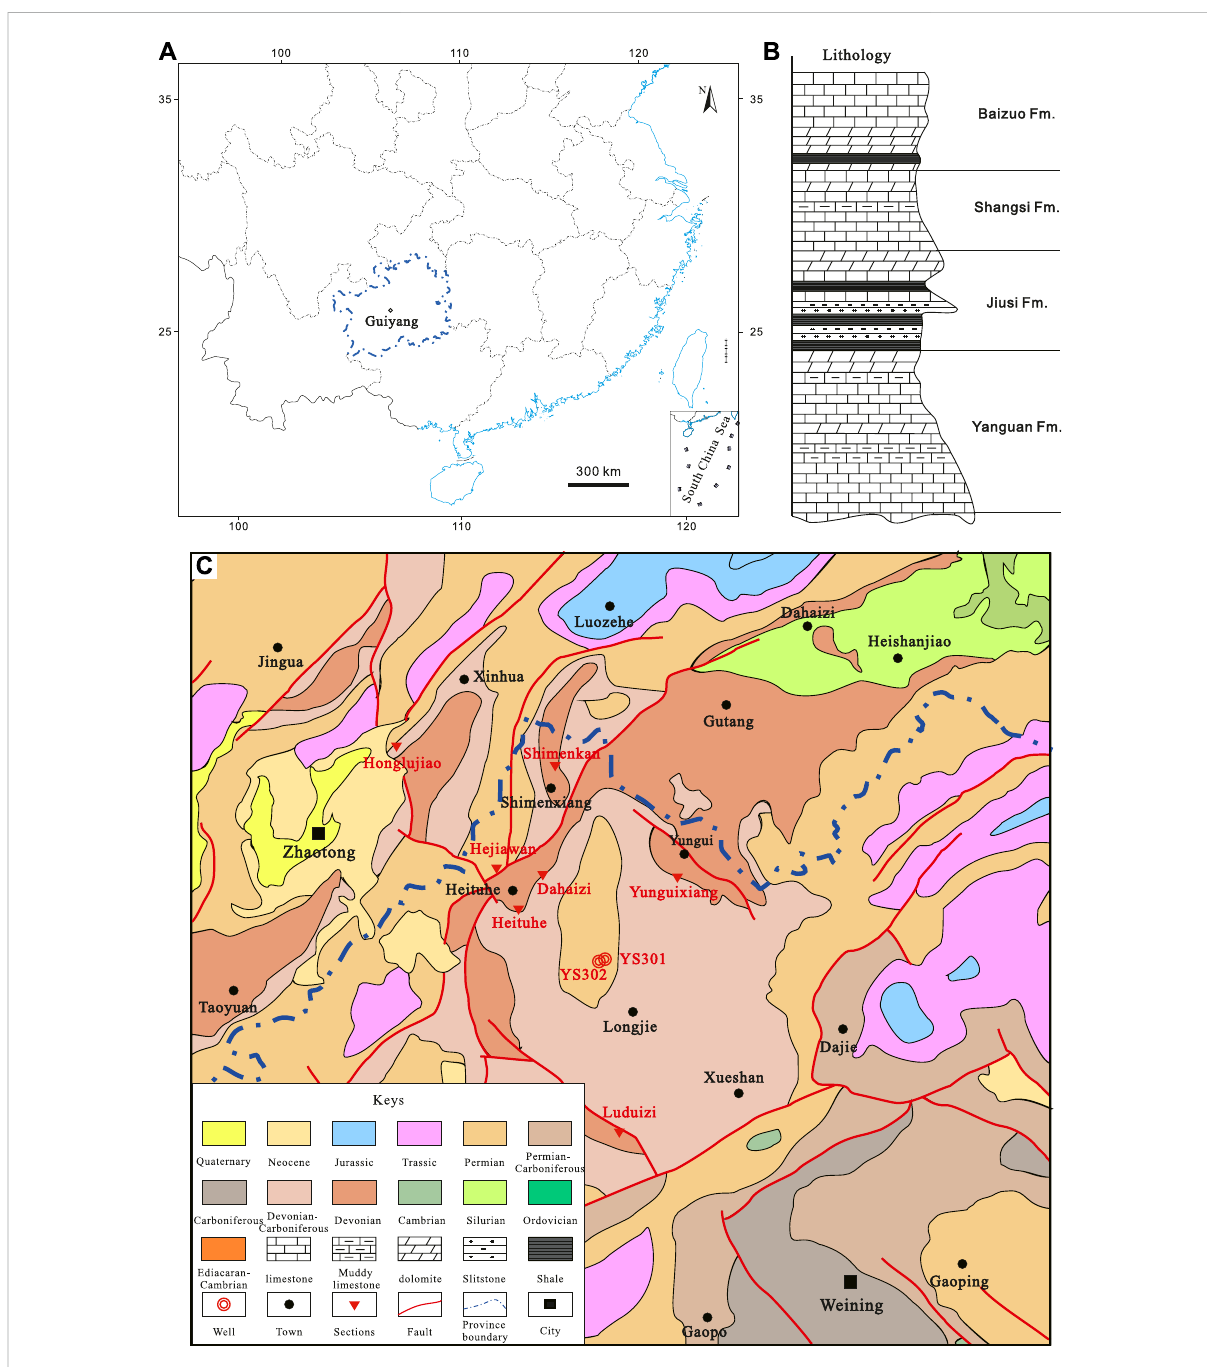
FIGURE 1 Location and general geological structure of the study area. (A) Occurrence of Guizhou Province in China. (B) The lithology of the Lower Carboniferous in the study area, northeastern Guizhou (modi fi ed after Zhang et al., 2017). (C) Geological map of the area studied (1:1000000), triangles mark the location of the sections of the Jiusi